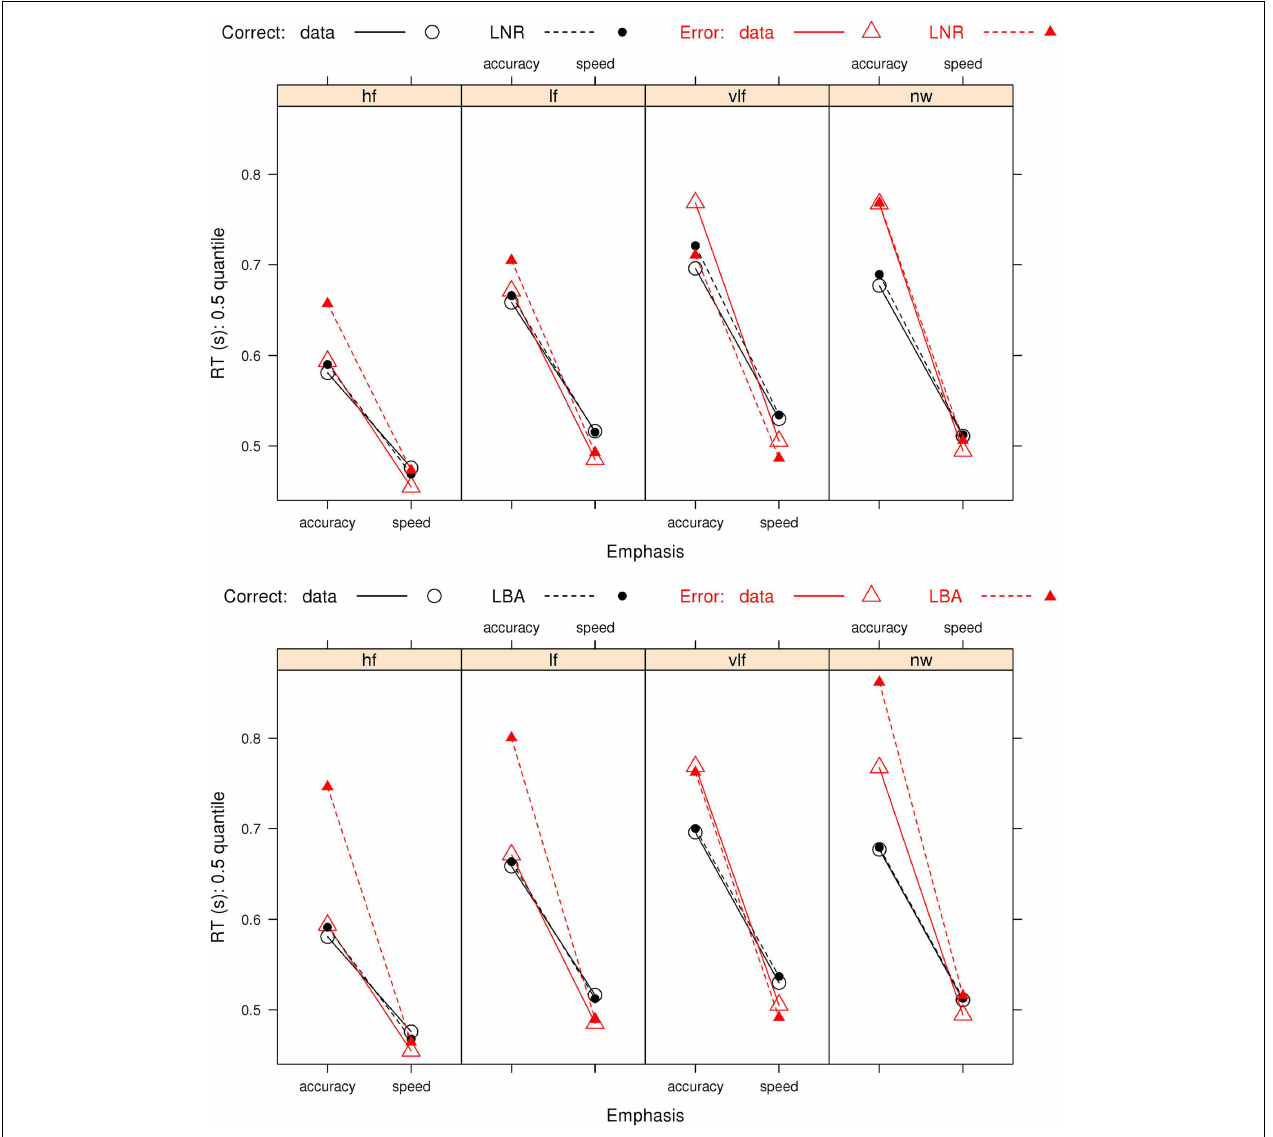
σ 2 ∼ E ∗ C & t 0 ∼ E ) and best (selected byAIC) LBA ( B ∼ lR ∗ E & A ∼ E & v ∼ W ∗ C & sv ∼ E ∗ C & t 0 ∼ E ) models: hf, high-frequency words; lf, low-frequency words, vlf, very low-frequency words; nw,